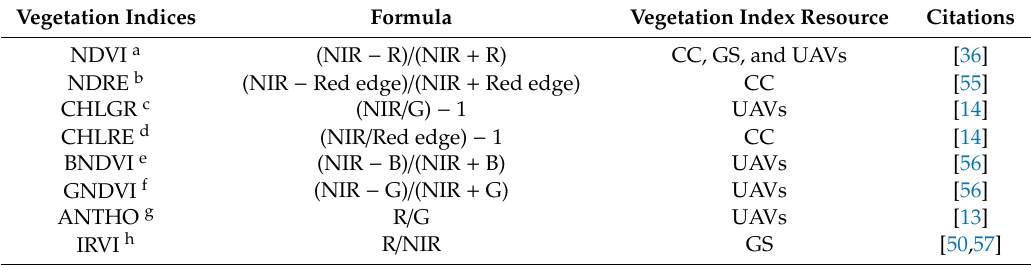
Figure 3. Data processing workflow for GeoTIFF from the RGB, NIR, and thermal Altum sensor images captured by the Phantom DJI and Inspire 2. Table 3. Summary of the spectral reflectance data used in this